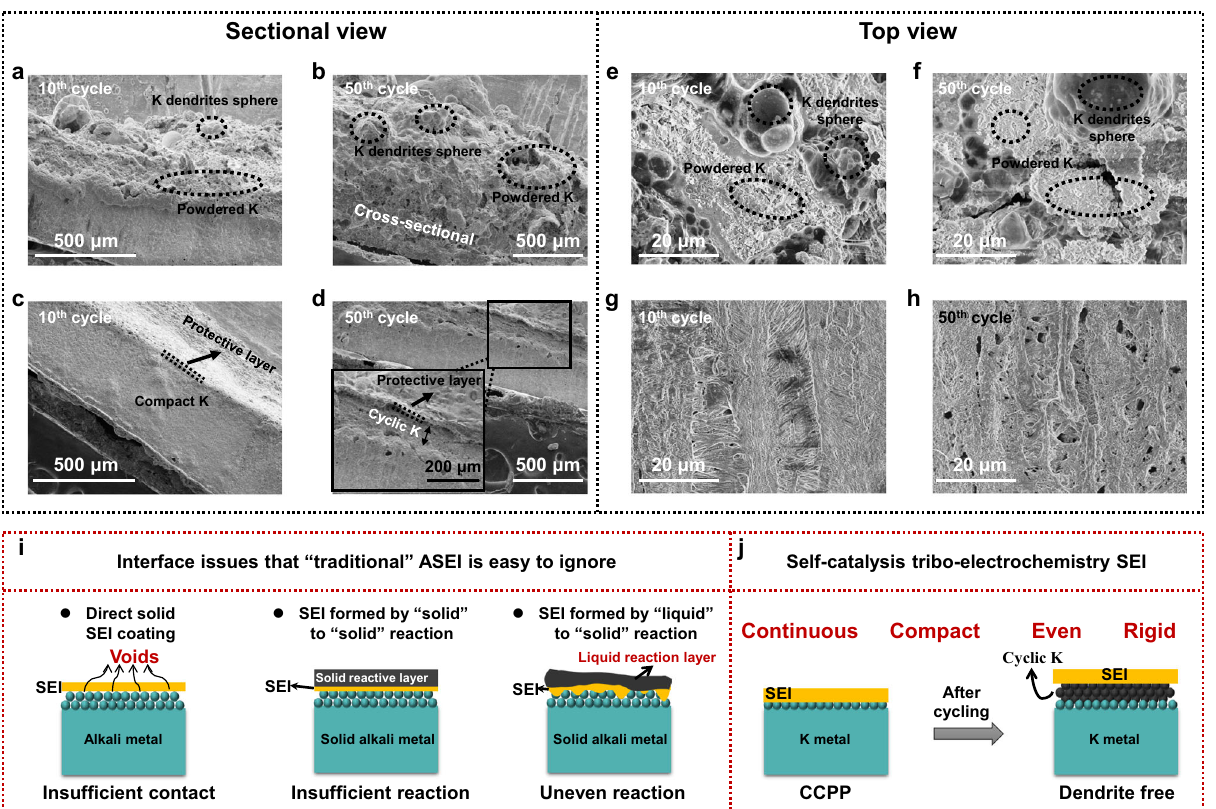
Fig. 5 SEM images of CCPP and pristine K after cycling and the advantages of SEI constructed by self-catalysis tribo-electrochemistry reaction. a , b Cross-sections of pristine K after ( a ) 10 and ( b ) 50 loops. c , d Cross-sections of CCPP anode after ( c ) 10 and ( d ) 50 loops. e , f Top views of pristine K after ( e ) 10 and ( f ) 50 loops. g , h Top views of CCPP anode after ( g ) 10 and ( h ) 50 loops. i Interface issues often ignored by three “ traditional ” ASEI construction strategies. j Inhibition of dendrites by CCPP electrode, which SEI constructed by self-catalysis tribo-electrochemistry